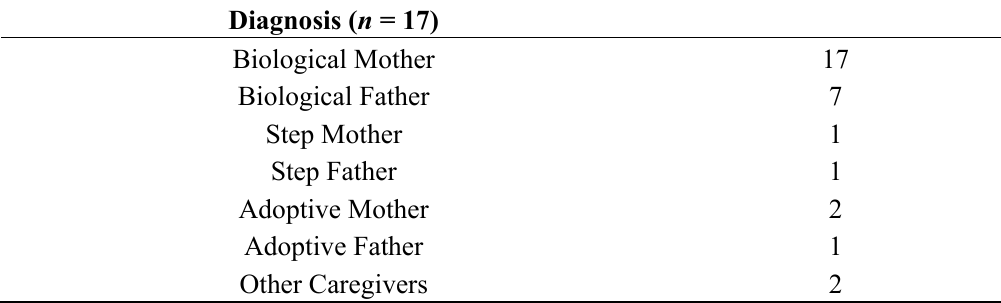
Table 1. Caregiver participants and their relationship to the youth in treatment.